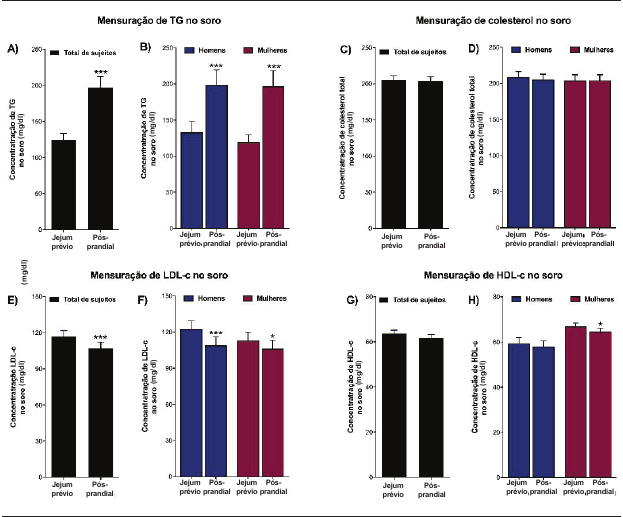
Figura 1 − Perfil lipídico de indivíduos mensurado após jejum prévio de 12 horas e de forma pós-prandial A figura mostra a concentração de TG no soro (A), colesterol total (C), LDL-c (E) e HDL-c (G) no total dos voluntários ( n = 50) avaliados, bem como a concentração de TG no soro (B), colesterol total (D), LDL-c (F) e de HDL-c (H) quando eles foram separados entre homens ( n = 21) e mulheres ( n = 29). Os dados representam a média ± o erro padrão da média.